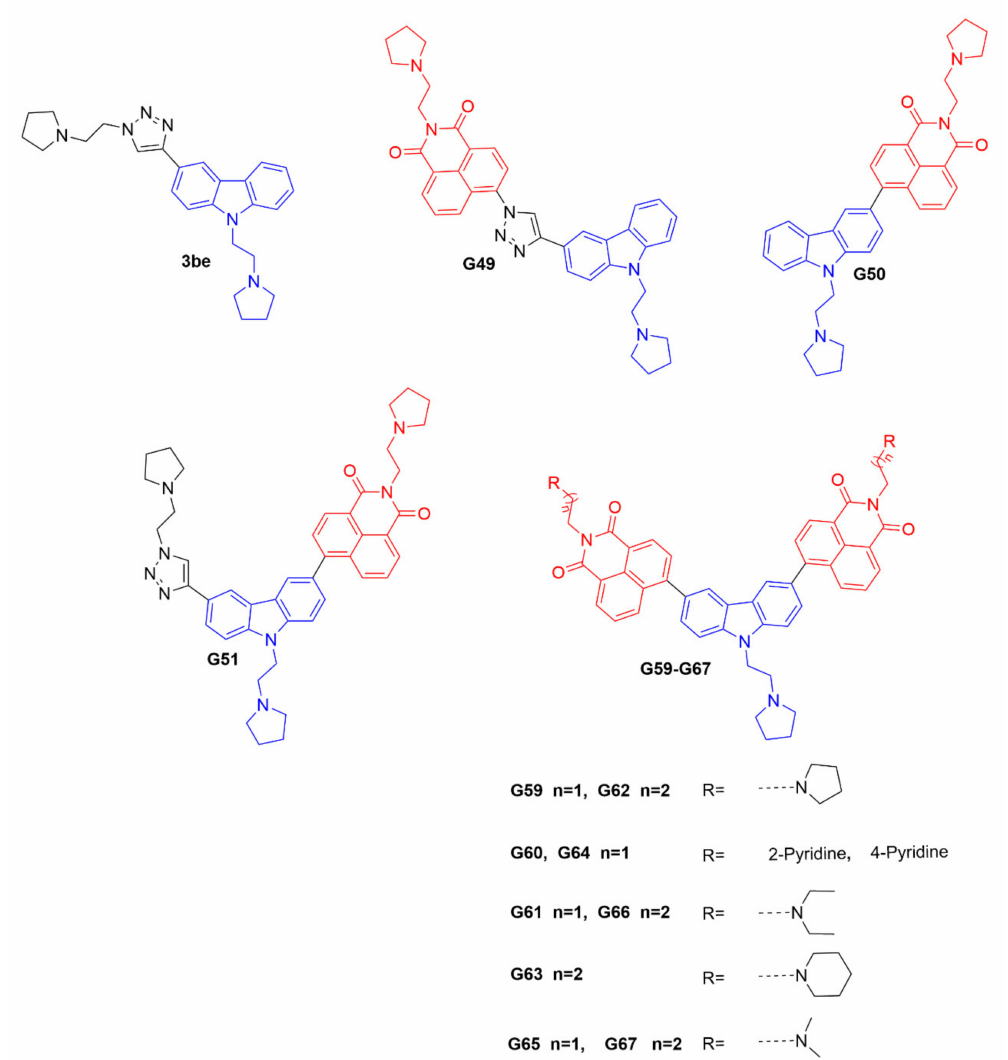
Figure 1. Chemical structures of 3be and our carbazole derivatives as potential fluorescent